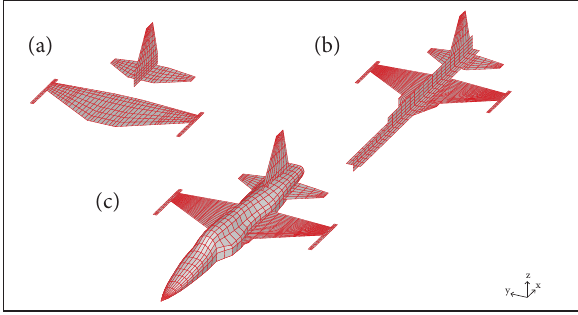
Figure 1. Flat plate (a), cruciform (b) and body aerodynamic models